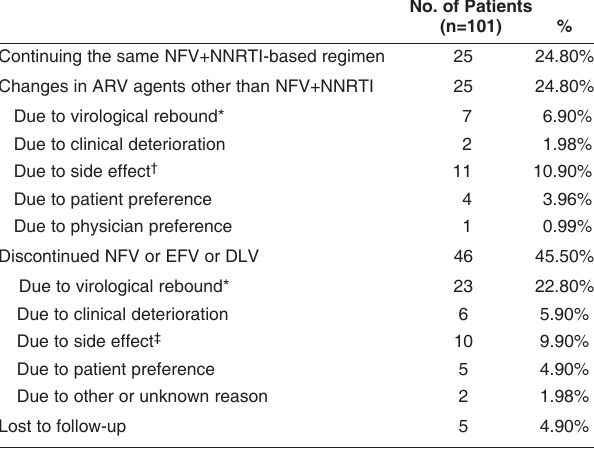
TABLE 3 Patient disposition at time of